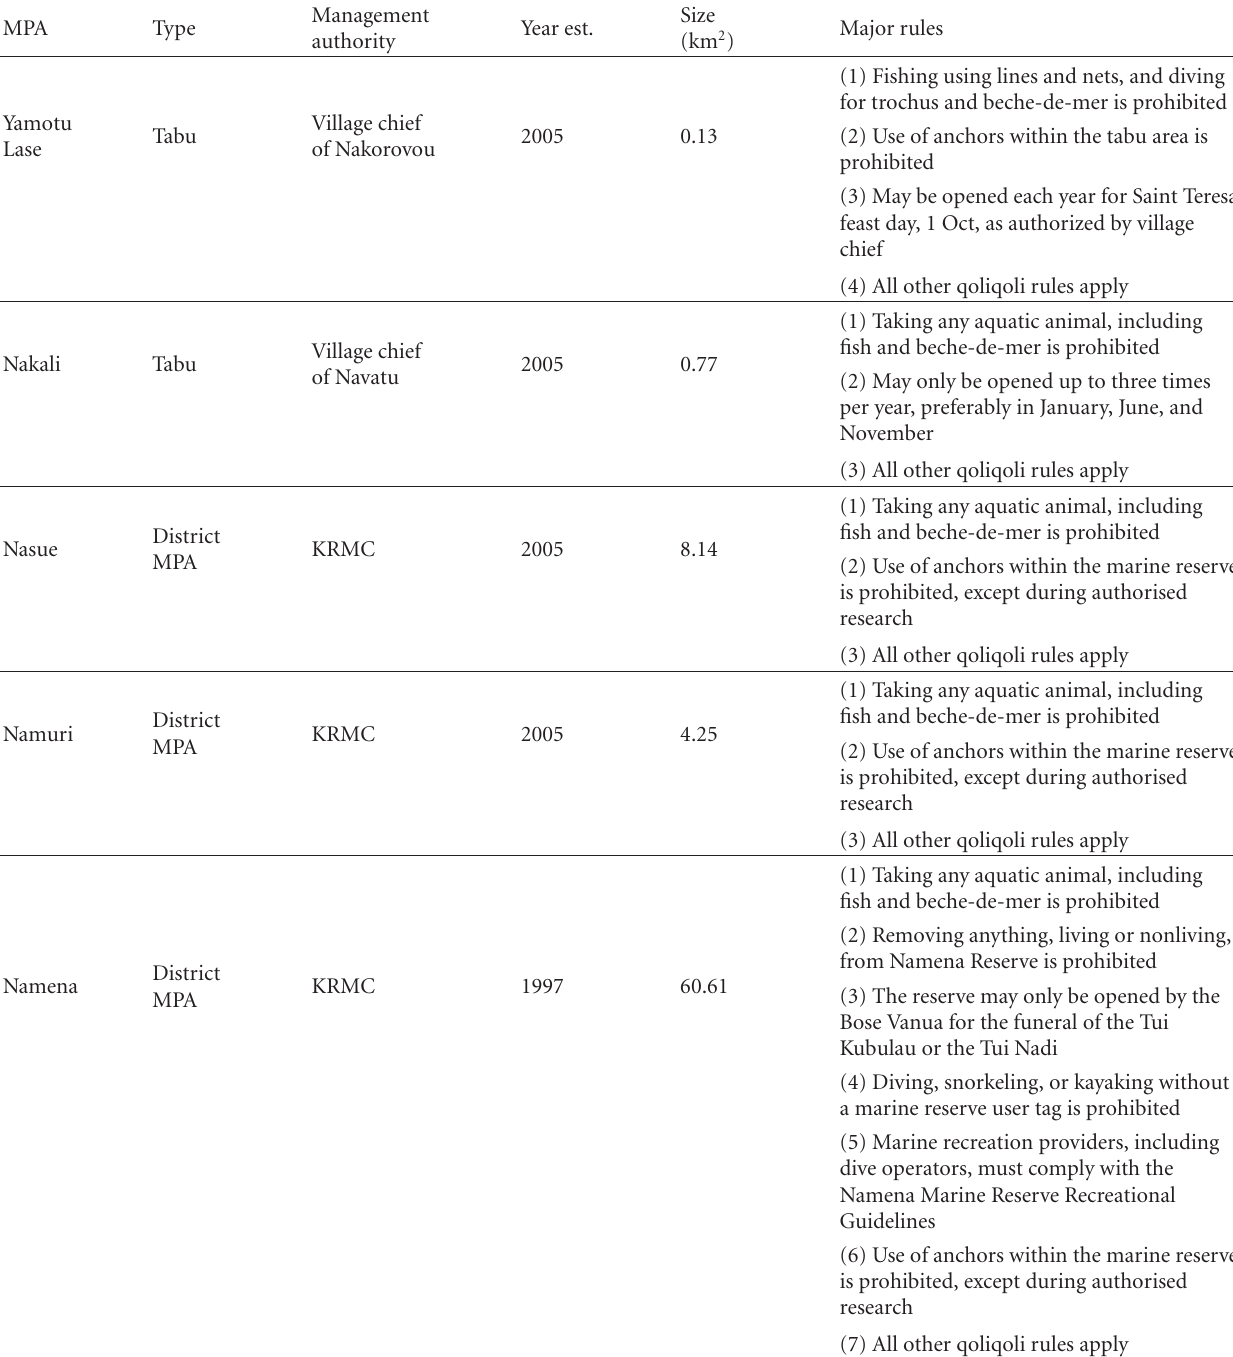
Table 1: List of MPA type, governance, date of establishment, size, and major management rules from the Kubulau Ecosystem-Based Management Plan [22]. KRMC = Kubulau Resource Management